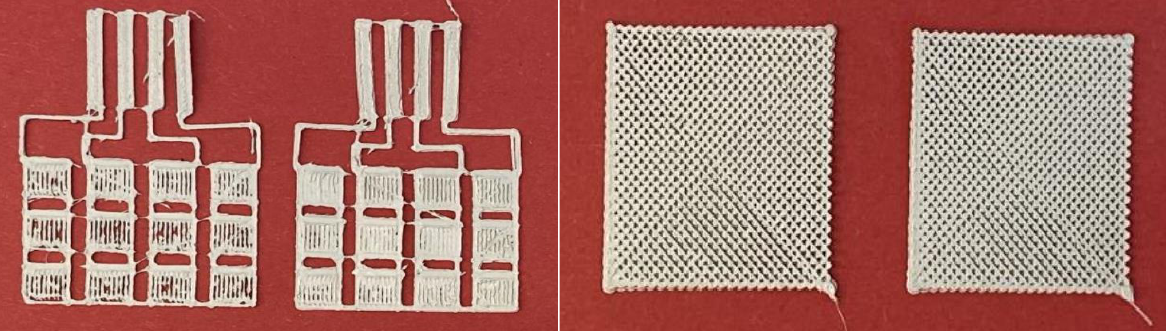
Figure 21. Structures with two deposition